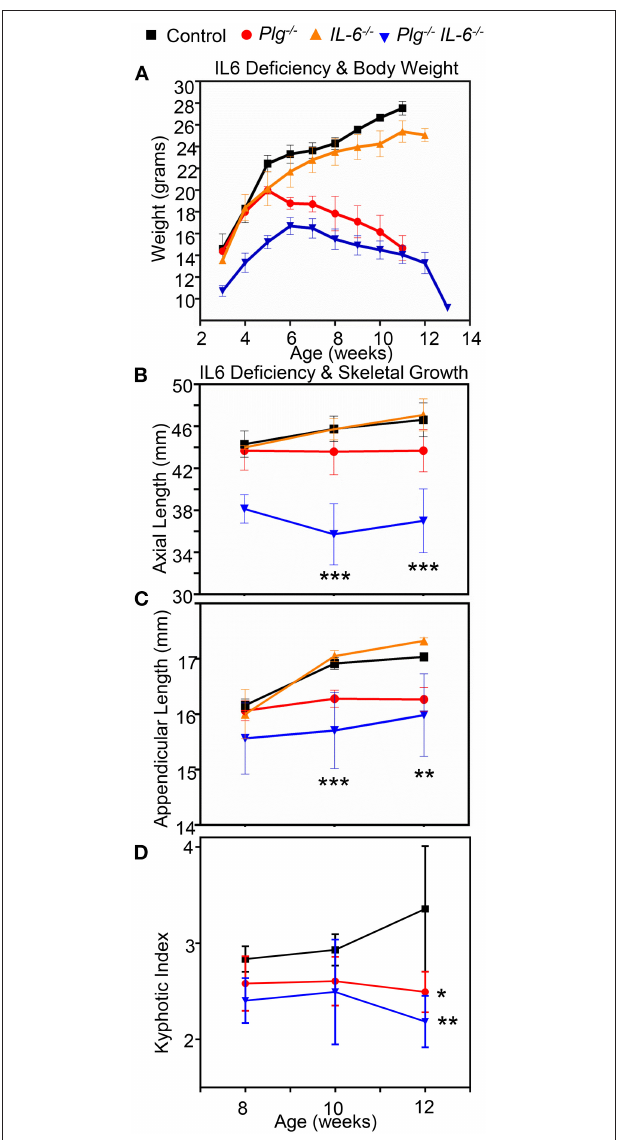
FIGURE 6 | Reduction of interleukin-6 does not rescues the skeletal growth phenotypes seen in mice with impaired fibrinolysis. (A) Comparison of Plg − / IL6 − / − , Plg − / − , IL6 − / − mice and WT littermate controls weight curve from 3 to 13 weeks shows a significant difference in the Plg −\− IL6 −\− compared to control. (B) Axial length as measured by radiographic tibial analysis shows significant differences at 10 and 12 weeks of IL6 − / − Plg − / − compared to control wildtype mice. (C) Appendicular length as measured by radiographic vertebral analysis demonstrates significant differences in IL6 − / − Plg − / − compared to control mice at 10, and 12 weeks. (D) Kyphotic index as measured by radiographic analysis was likewise significantly different in both Plg − / − and IL6 − / − mice compared to control mice at 12 weeks of age. *** p < 0.001, ** p < 0.01, and * p < 0.05 respectively. Error bars represent SD. See Supplementary Table 2 for quantification and statistical analysis.